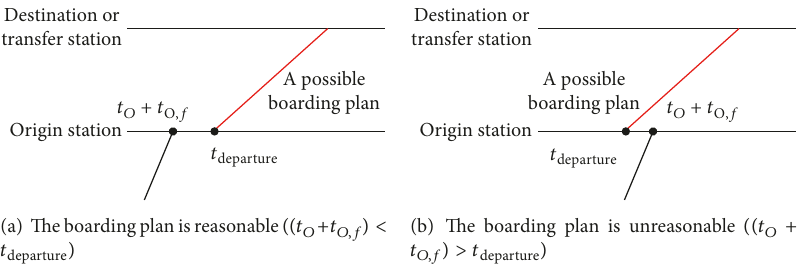
Figure 5: Comparisons of the calculated departure time of the possible boarding plan versus the passenger’s arrival time on the platform. Note. 𝑡 𝑂 is the entry time of the given passenger at the origin station; 𝑡 𝑂,𝑓 is the walking time of passenger with the fastest speed from the entry gate to the platform at the origin